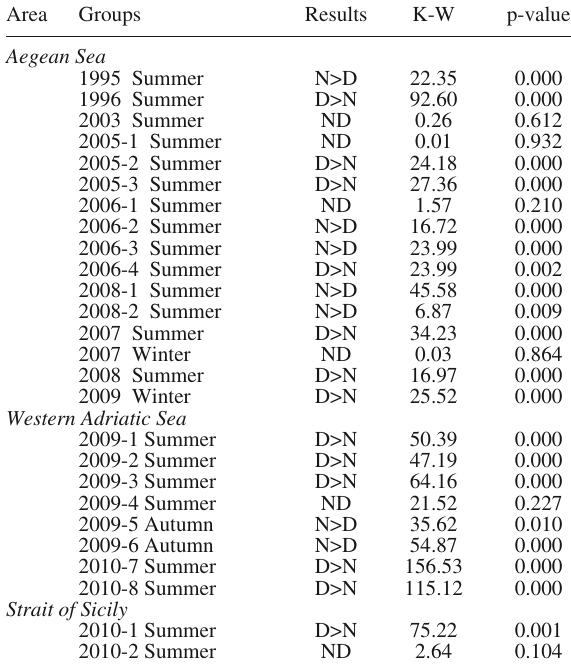
t able 5 . – Anchovy. Results of the Kruskal-Wallis test (K-W) com- parisons in each pair of hauls applied to anchovy length frequency distributions. D, Day; N, Night; ND, No